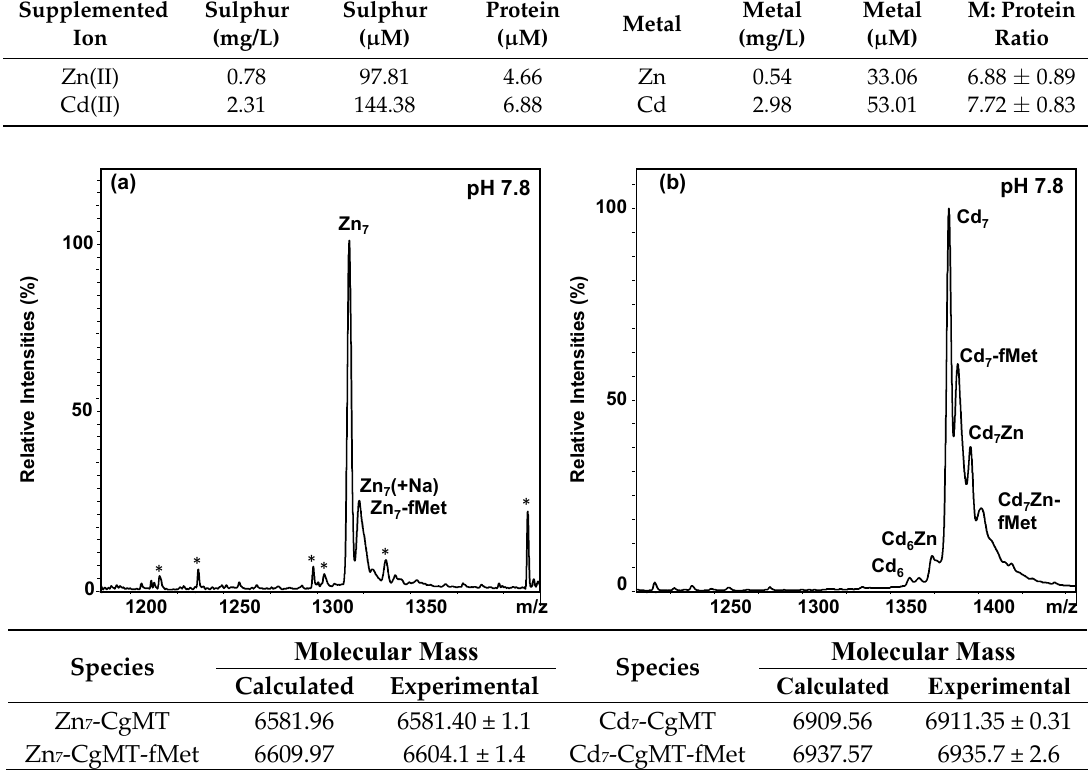
Table 1. Metal stoichiometry of recombinant CgMT protein expressed in presence of Zn(II) or Cd(II), as determined by elemental analysis (ICP-OES).